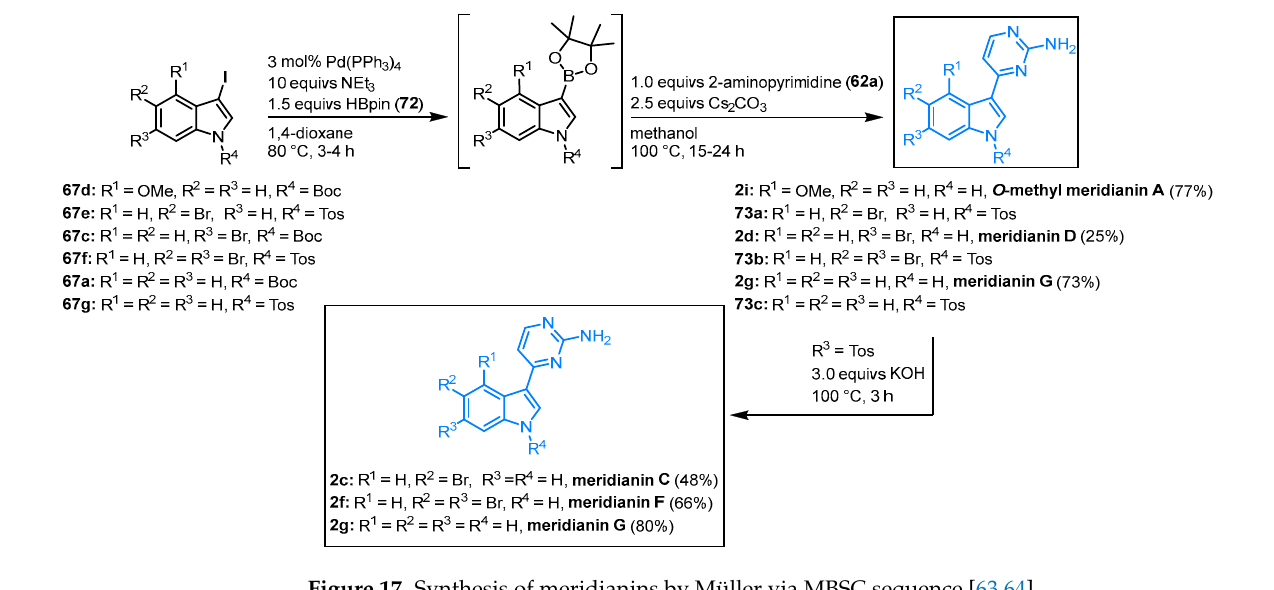
Figure 17. Synthesis of meridianins by Müller via MBSC sequence [63,64].